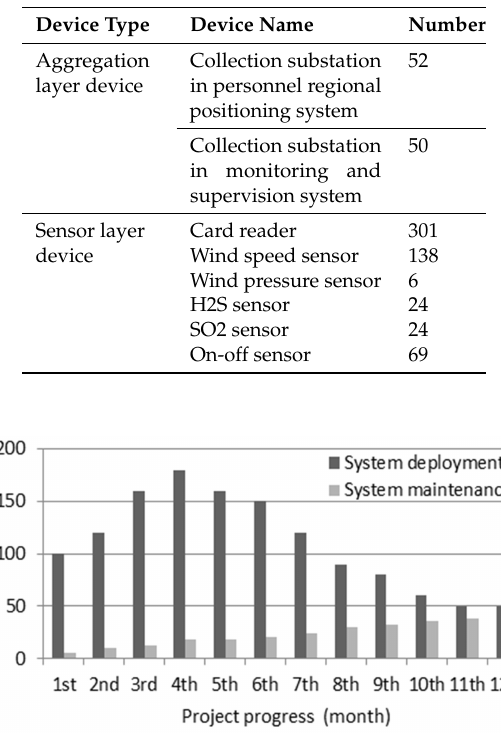
Figure 2. The labor costs of deployment and maintenance in “Six Systems” of